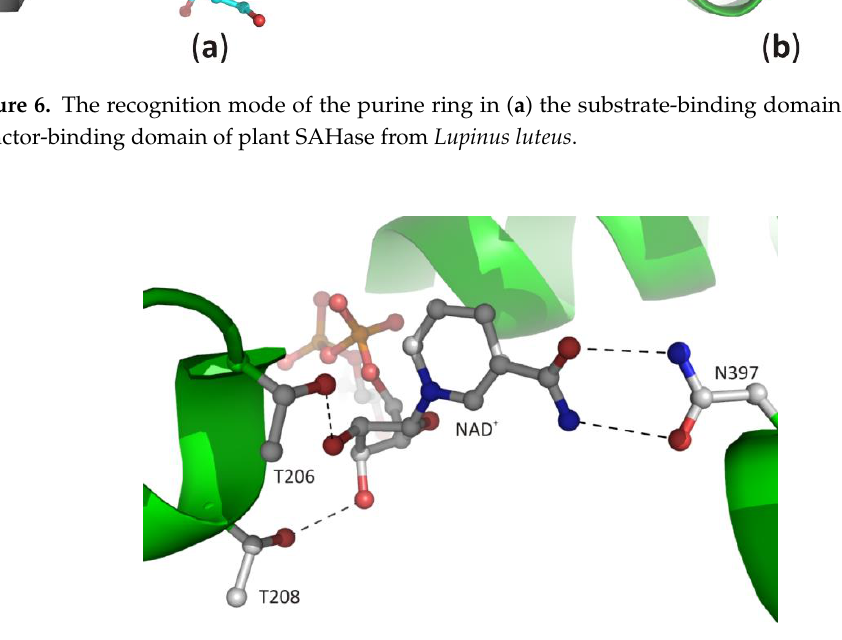
Figure 7. The recognition mode of the nicotinamide riboside moiety of the bound cofactor in plant SAHase from Lupinus luteus